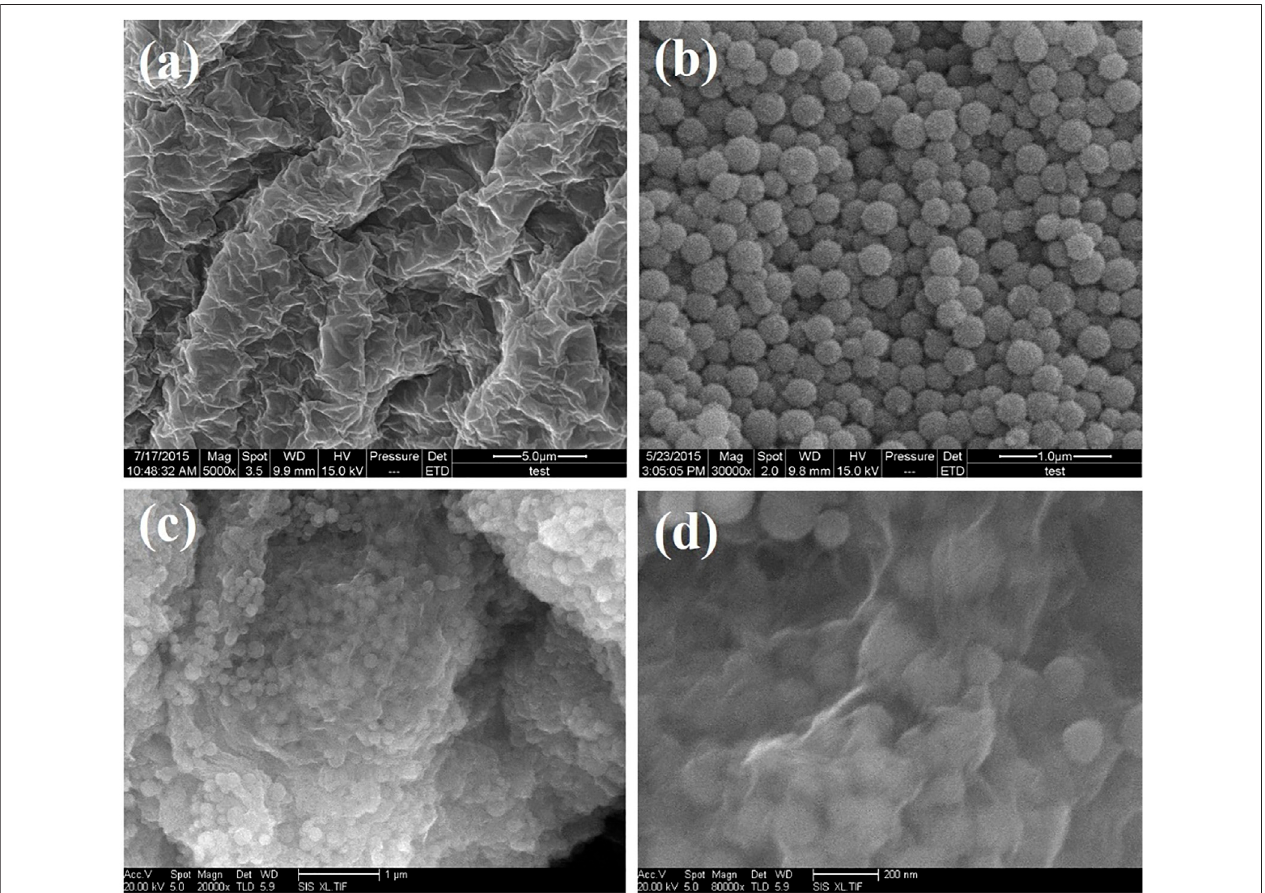
FIGURE 2 | SEM images of graphene oxide (A) , SnO 2 @C (B) , and SnO 2 @C/graphene (C,D) samples.